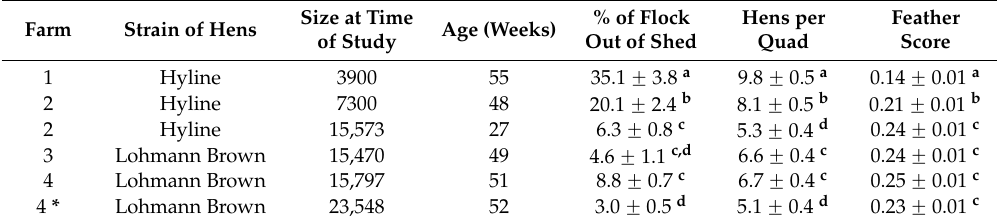
Table 3. Flocks and their characteristics including strain, number of hens at time of study and age in weeks. Means for % of flock out of shed, hens per quadrat and feather score are reported for each flock. Size at Time % of Flock Hens per Age (Weeks) Farm Strain of Hens Out of Shed of Study